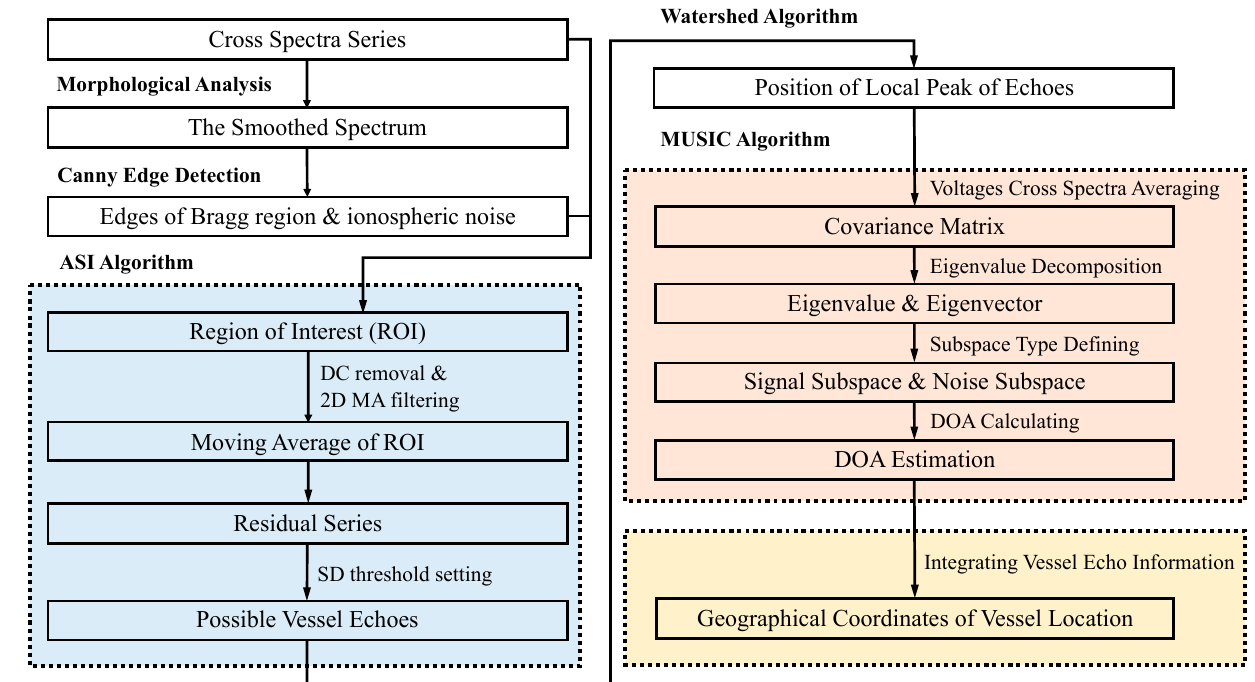
Figure 3. Scatter diagram of moving windows and noise.